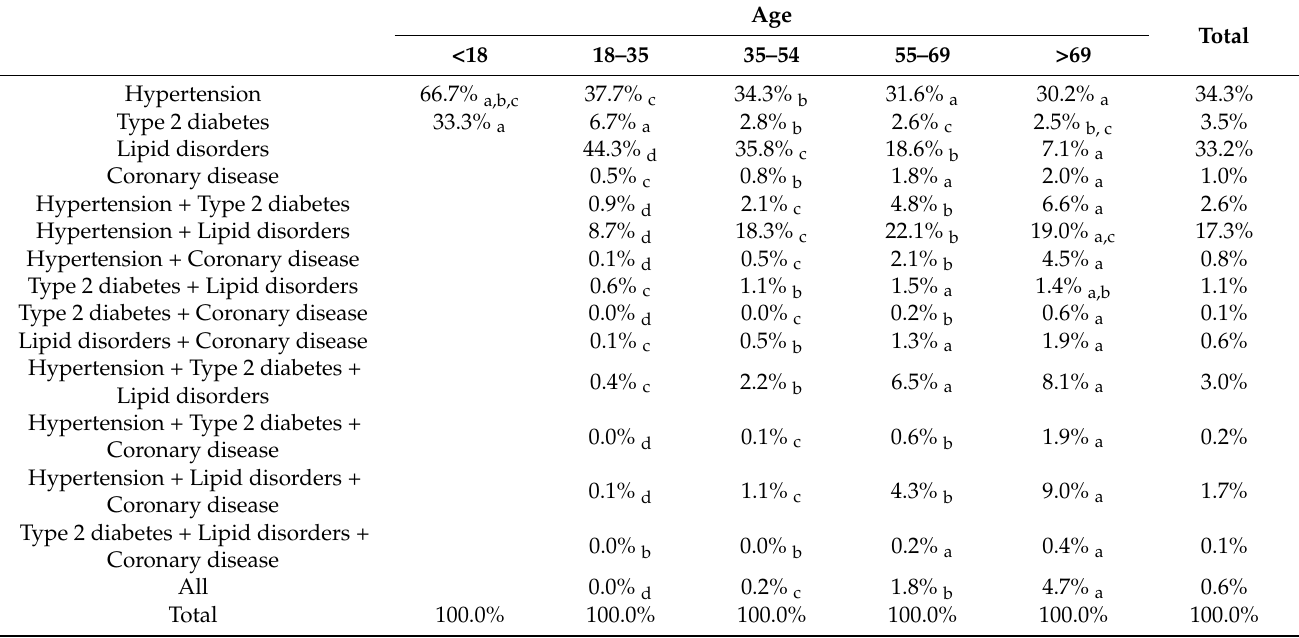
Table 9. Relationship between age and comorbidities; data presented as percentage of age group 1